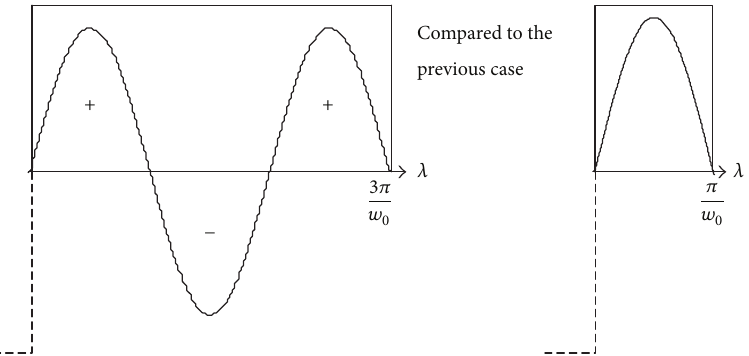
(𝑡) are now one-third as effective as before. The reader is asked (this will soon be inp